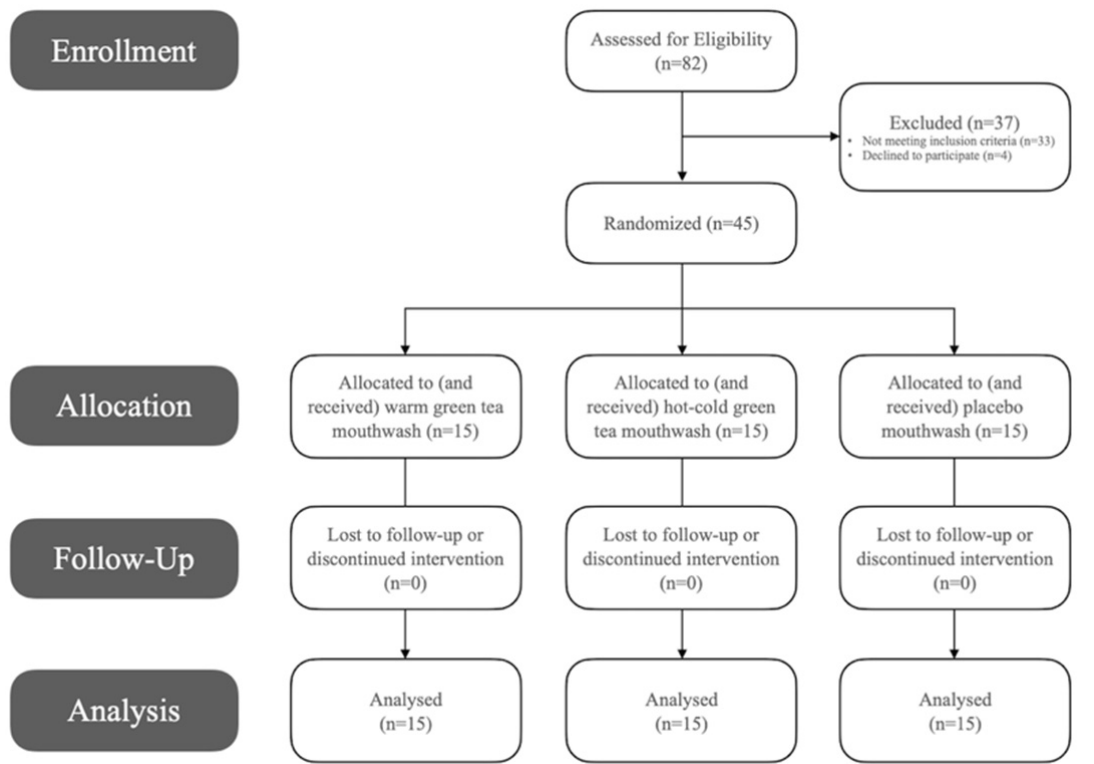
Figure 1. Flow diagram demonstrating enrollment, exclusion, group allocation and follow-up of study participants.